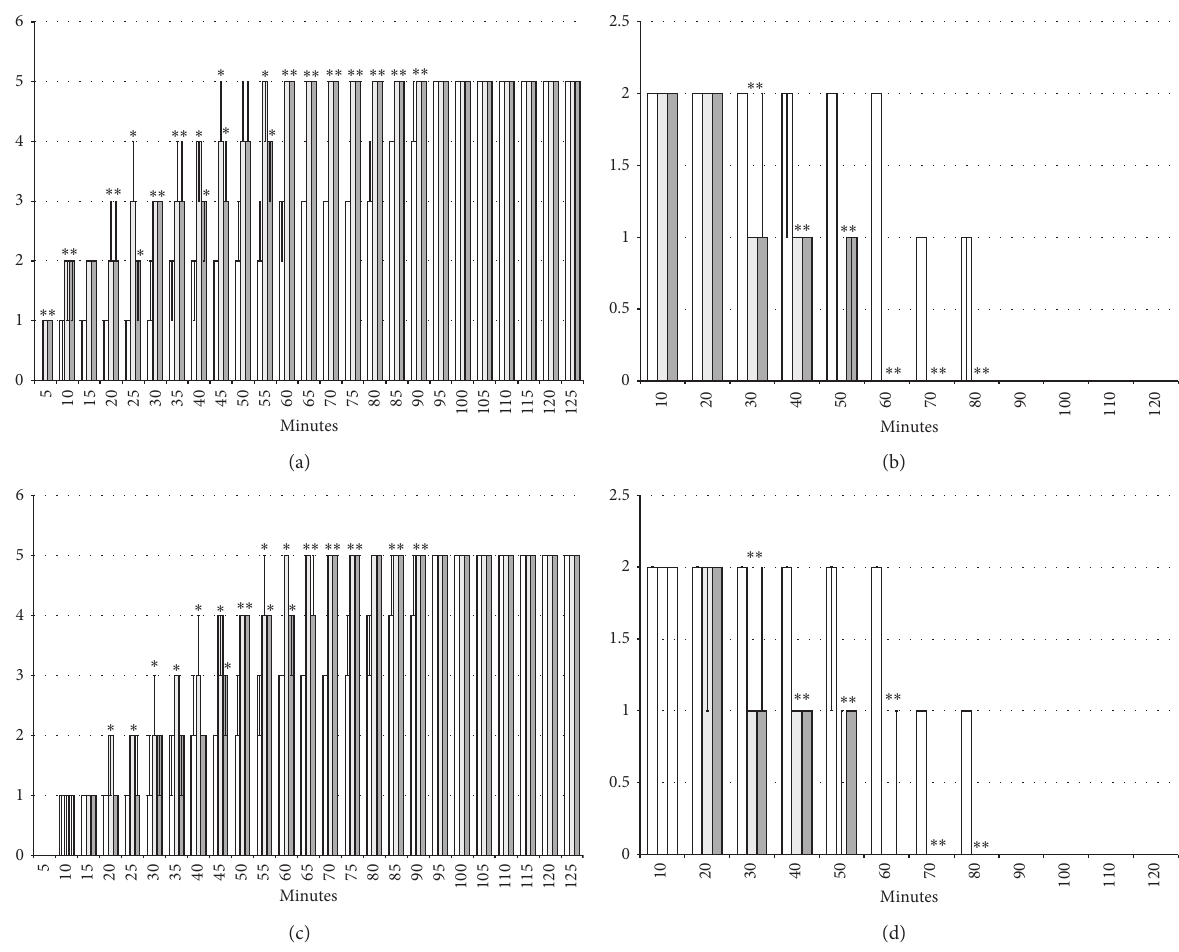
Figure 3: Axillary block: left brachial plexus perineural anesthesia produced considerable and long-lasting function failure of the affected fore limb and an inability to walk and to grasp (left) along with considerable fore limb oedema in the anesthetized rats (right) (white bars) which BPC 157 opposed (gray bars). Prophylactic effect: BPC 157 medication (gray bars) (10 μ g/kg (light gray bars), 10 ng/kg (dark gray bars) intraperitoneally) given immediately after lidocaine (upper) considerably counteracted lidocaine-induced course. Therapy effect: BPC 157 medication (gray bars) (10 μ g/kg (light gray bars), 10ng/kg (dark gray bars) intraperitoneally) given later (after 10 minutes) (lower) considerably counteracted lidocaine-induced course. (a), (b) Perineural anesthesia of the nerves of the left brachial plexus, scored 0–5, min/ med/max. (c), (d) Fore limb oedema with perineural anesthesia of the nerves of the left brachial plexus, scored 0–3; values are presented as min/med/max. ∗ P < 0 . 05 at least vs. control